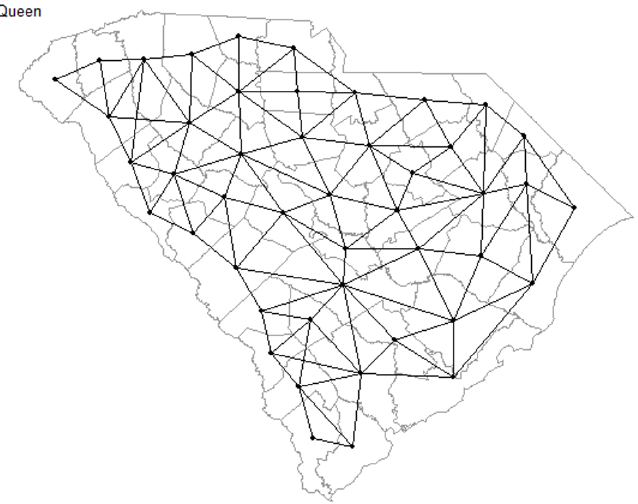
Figure 1. Contiguity Queen neighbors of counties in South Carolina.